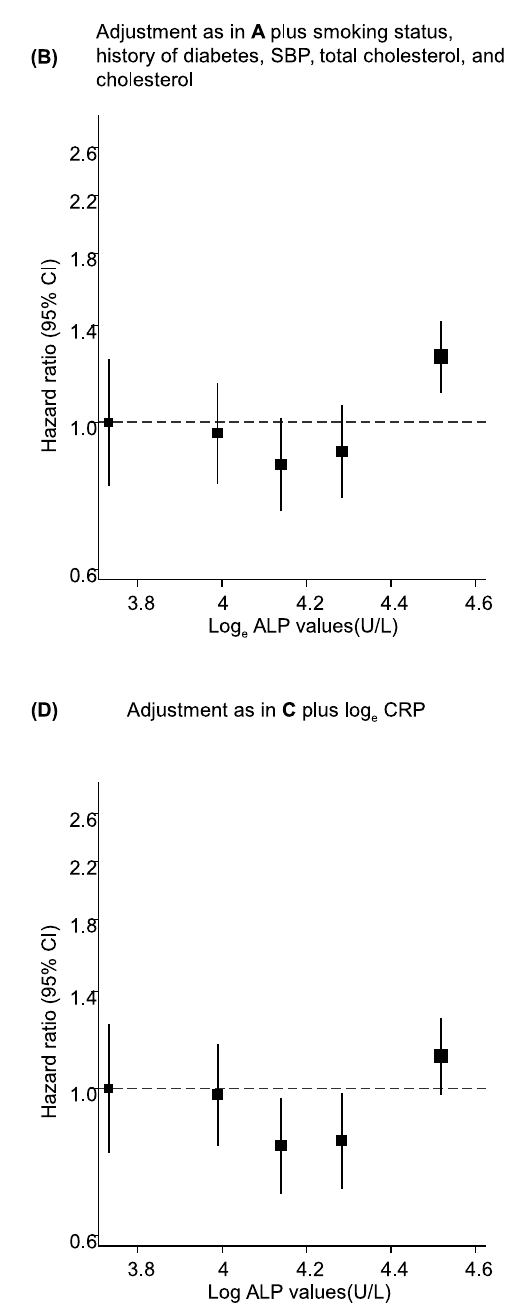
Fig 1. Hazard ratios for incident cardiovascular disease by baseline values of log e alkaline phosphatase using floating absolute risks. A , adjusted for age and sex; B , adjustment as in A plus smoking status, history of diabetes, systolic blood pressure, total cholesterol, and high-density lipoprotein cholesterol; C , adjustment as in B plus body mass index, alcohol consumption, glucose, log e triglycerides, estimated glomerular filtration rate (as calculated using the Chronic Kidney Disease Epidemiology Collaboration combined creatinine-cystatin C equation), and log e urine albumin excretion; D , adjustment as in C plus log e C-reactive protein; the size of the box is proportional to the inverse of the variance of hazard ratio.